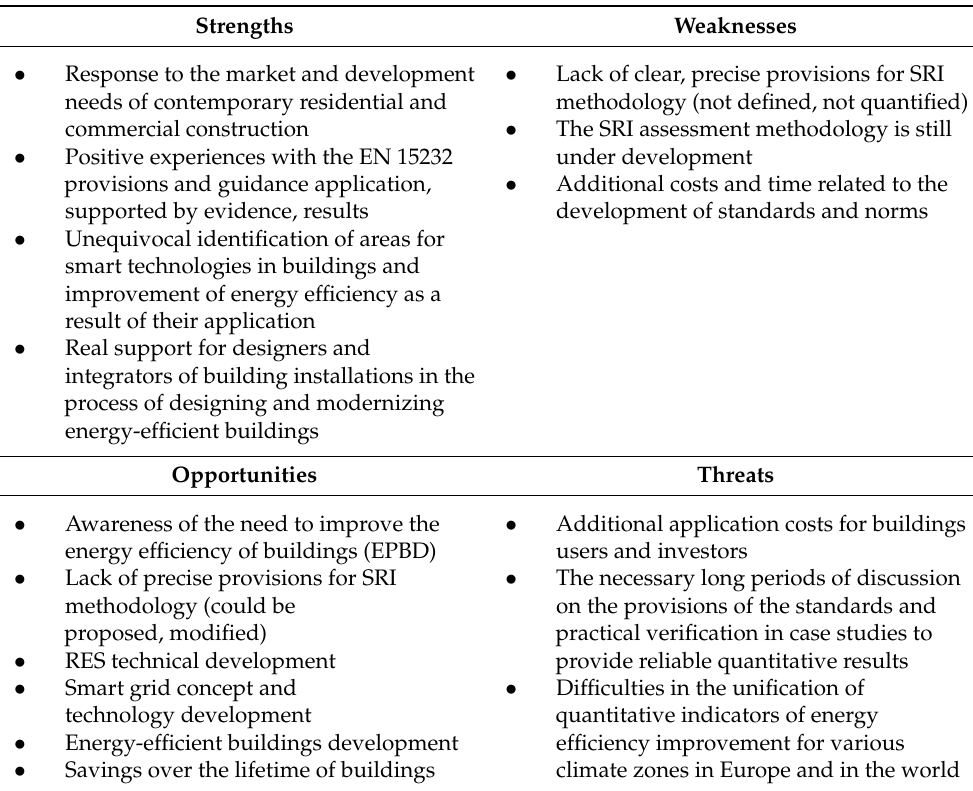
Table 7. Integration of the EN 15232 standard and SRI assessment methodology–SWOT analysis.